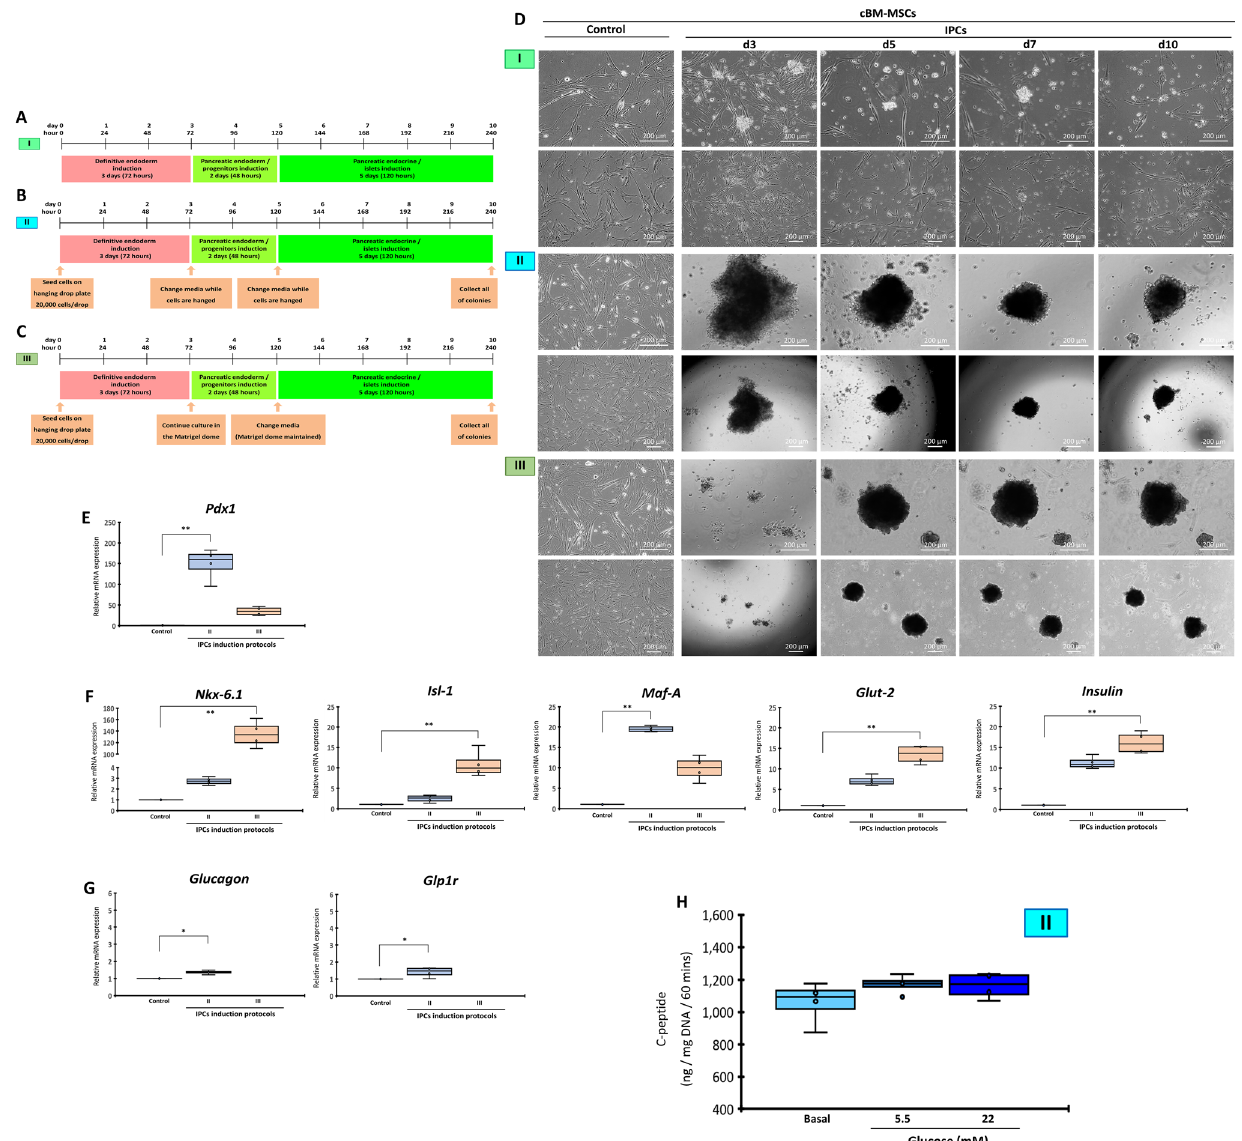
Figure 2. Generation of cBM-MSC-derived IPCs by microenvironment manipulation. The diagrams of three culture techniques used for the generation of cBM-MSC-derived IPCs are shown: (I) low attachment ( A ), (II) hanging-drop ( B ), and (III) hydrogel-embedded ( C ) culture techniques. Morphological appearances of cells that underwent each of induction technique were observed under a phase-contrast microscope with 100X and 200X magnification ( D ). mRNA markers relating to pancreatic endoderm ( E ), pancreatic beta-cell ( F ), and pancreatic-relating markers ( G ) were analyzed by RT-qPCR. mRNA expression was normalized with reference gene and undifferentiated control. Functional testing by glucose-stimulated C-peptide secretion (GSCS) was illustrated (H). Bars indicate a significant difference (*, p value < 0.05; **, p < the culture period (Fig. 5B). At day 10, approximately 834 colonies (median) were obtained from 1 × 10 6 seeding cells (Fig. 5C), and the colony size varied from < 50 µm to > 700 µm (Fig. 5D). The analysis of the pancreatic mRNA expression revealed that pancreatic beta-cell markers ( Nkx-6.1, Isl-1, secreted C-peptide under a basal condition and showed a trend of glucose-responsive C-peptide secretion upon high (22 mM) glucose stimulation. However, it was not statistically significant compared to basal secretion (Fig. 5G). The results suggested that the microenvironment-manipulating approach using the low attachment culture was efficient to generate IPCs from cAD-MSCs in terms of pancreatic islet characteristics. However, their func- tional property was still limited.